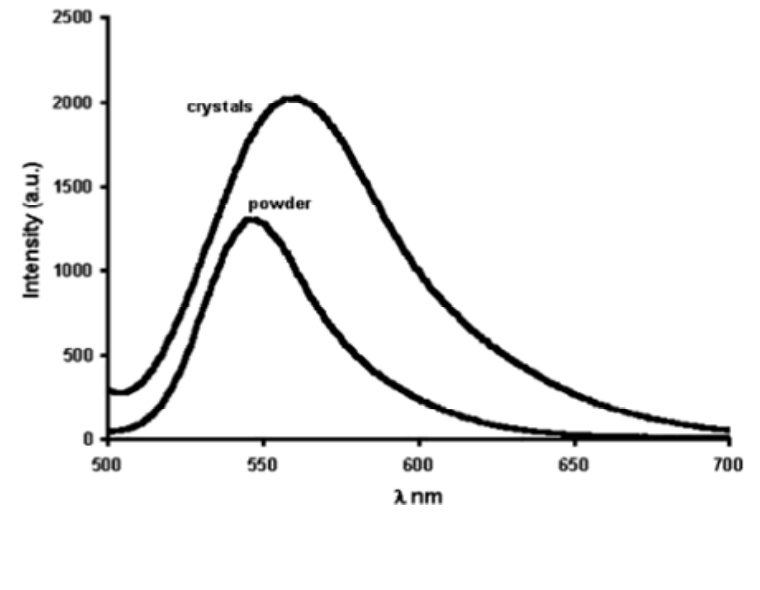
Figure 7. Comparison between emission spectra of crystals and powder